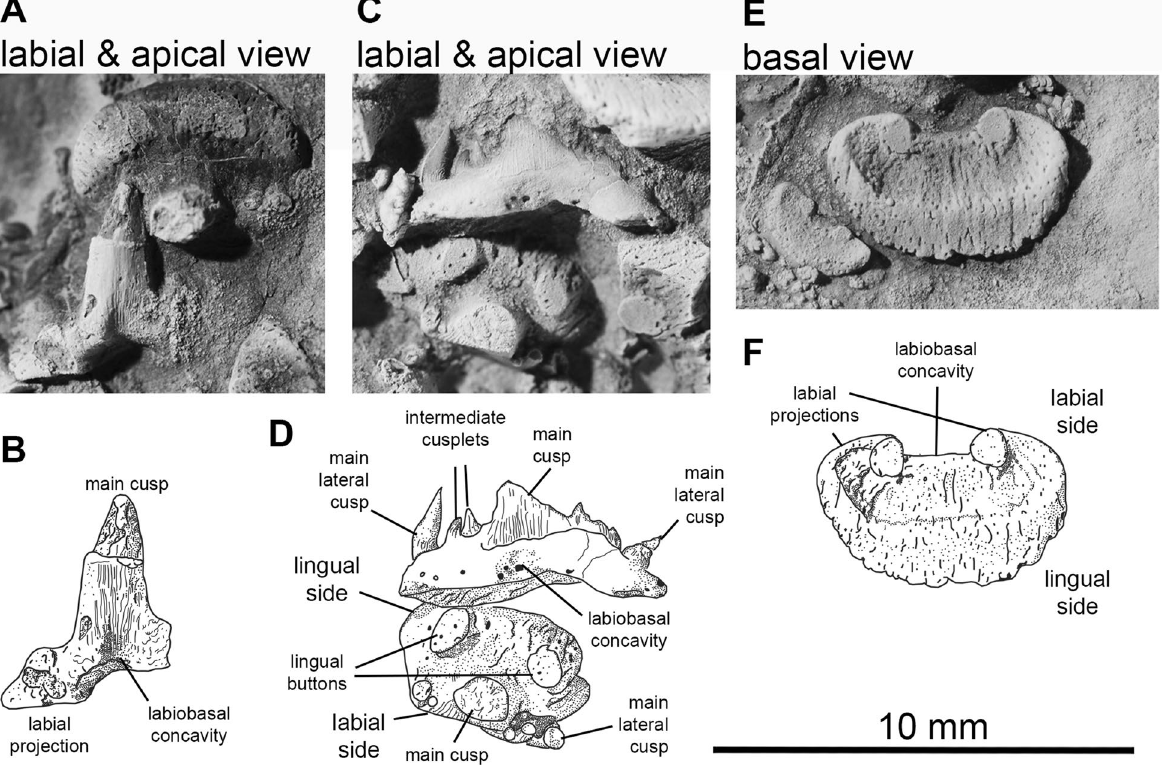
Fig. 7 Photos and drawings of the teeth of Maghriboselache mohamezanei n. gen. et sp., PIMUZ A/I 5160. 2 tooth rows. A , C , E , photos and B , D ,